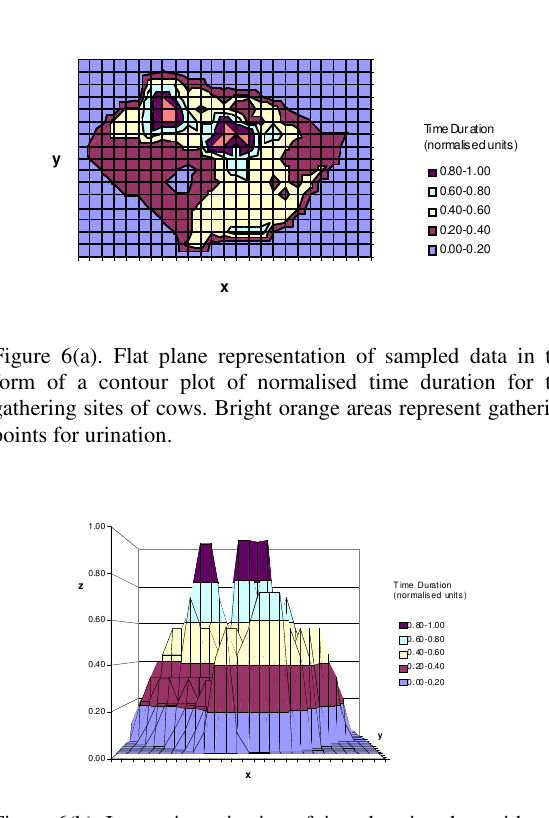
Figure 6(d). Information in Figure 6(c) has been rotated, thresholded ( t = 0.80) and binarised to separate the peaks from the background. The transect (yellow line) shows the difference between the estimated centre-of-mass positions for each gathering area, A and